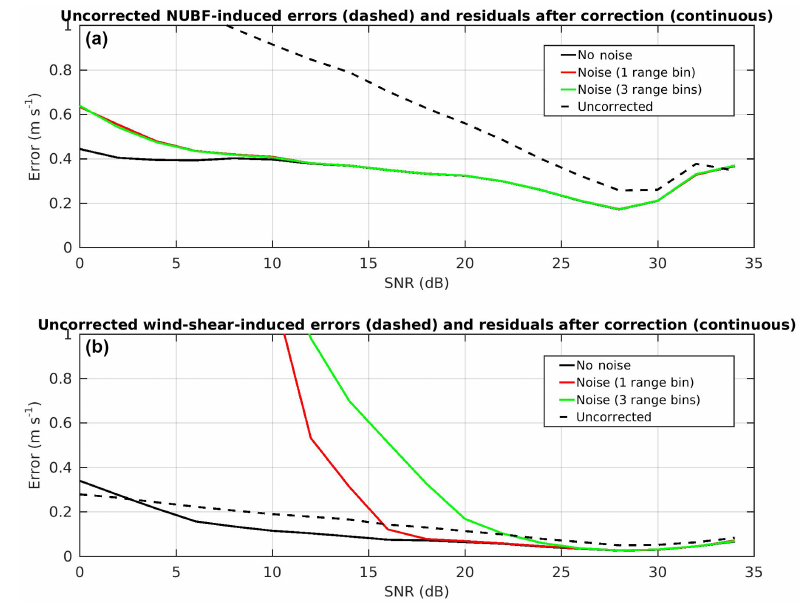
Figure 11. The NUBF-induced (a) and wind-shear-induced (b) root mean square errors as a function of the SNR computed (1) without noise (black solid lines), (2) with added noise and estimating gradients from variables at the native range resolution of 500m (red solid lines) and (3) with added noise and estimating gradients from variables computed from running averages over three range bins (green solid lines). The statistics are built from 8 days of CloudSat data. Initial uncorrected errors are plotted as black dashed